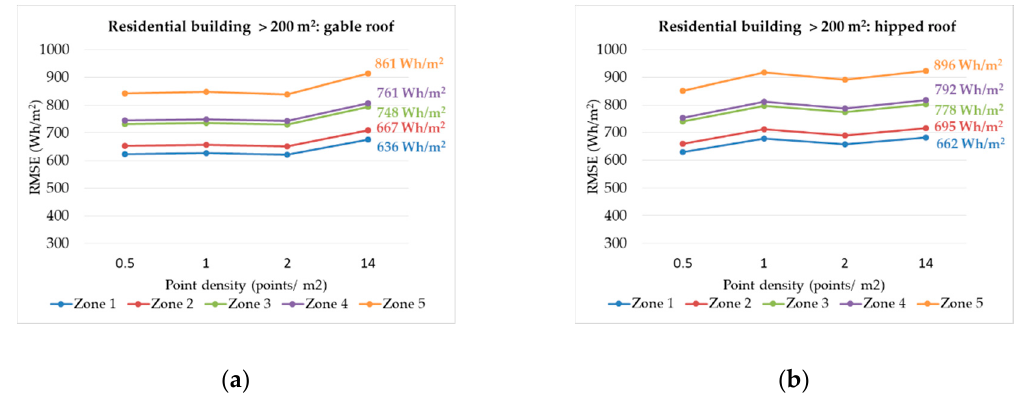
Figure 17. Average daily PV energy production per square meter loss (Wh / m 2 ) for residential buildings with a surface bigger than 200 m 2 : ( a ) gable roof, ( b ) hipped roof.